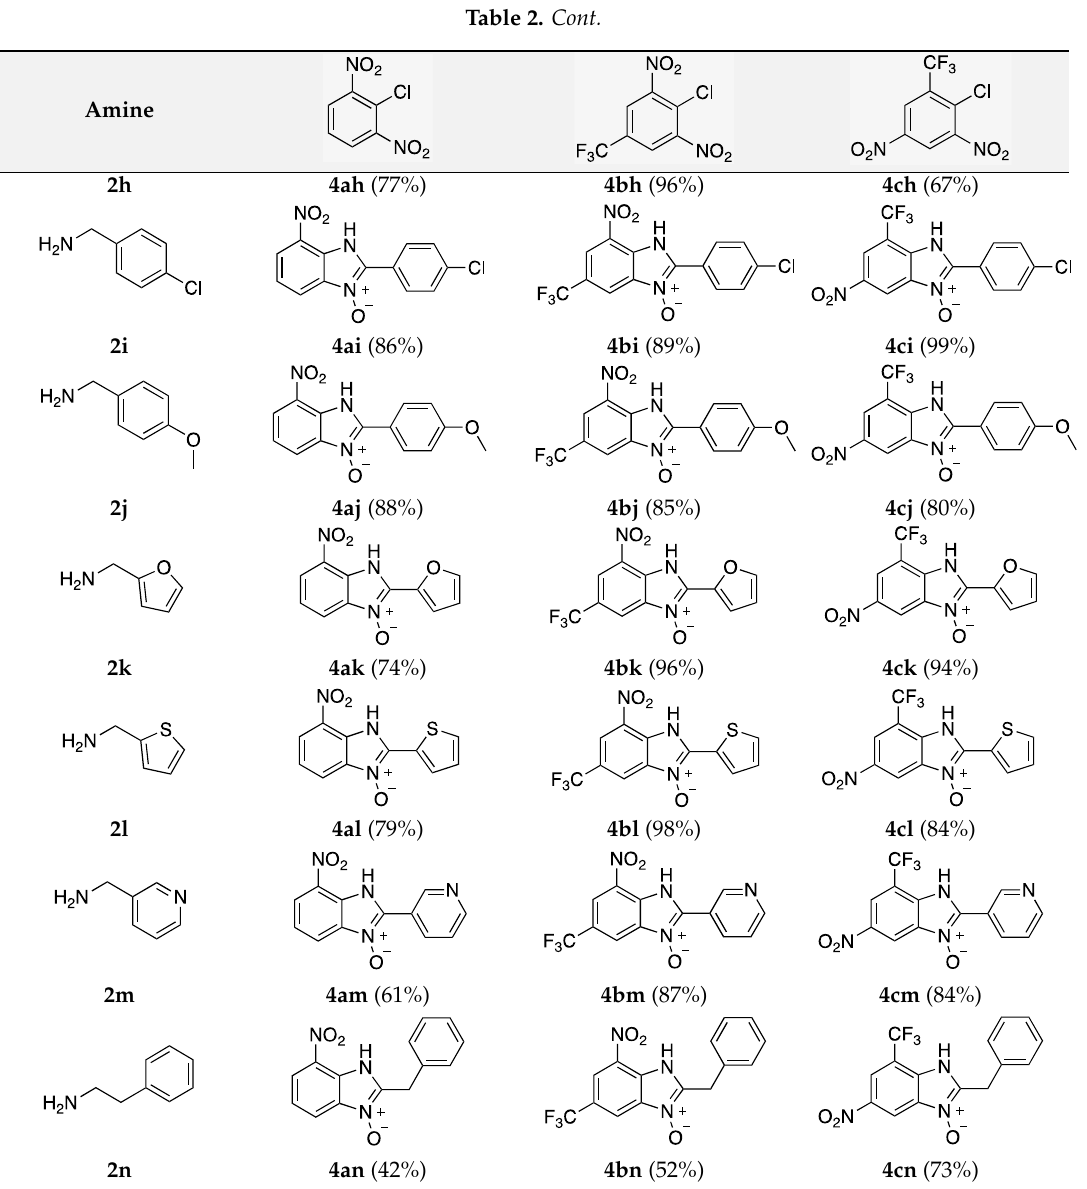
Table 2. Cont. Table 2. The library of 2-aryl-benzimidazole 3-oxides prepared in this study. a.